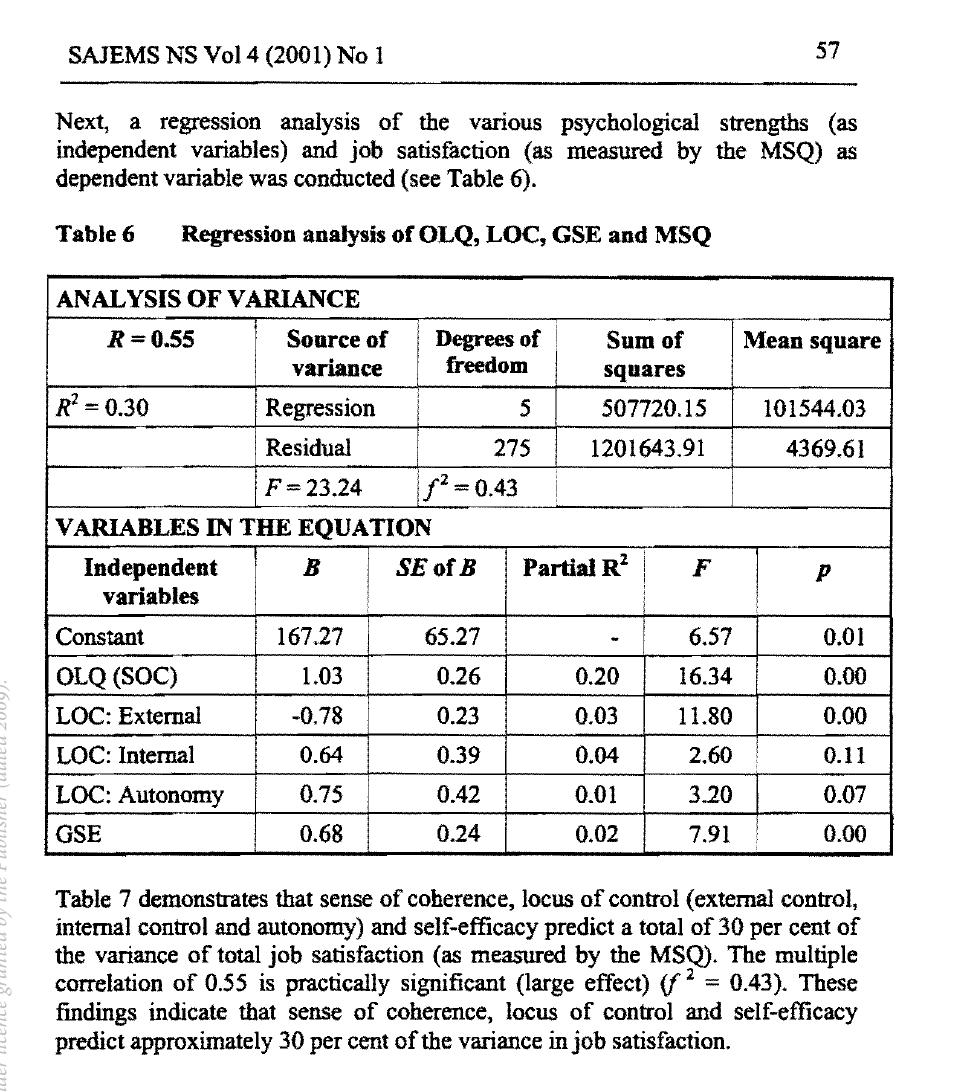
Regression analysis of OLQ, LOC, GSE and MSQ ANALYSIS OF